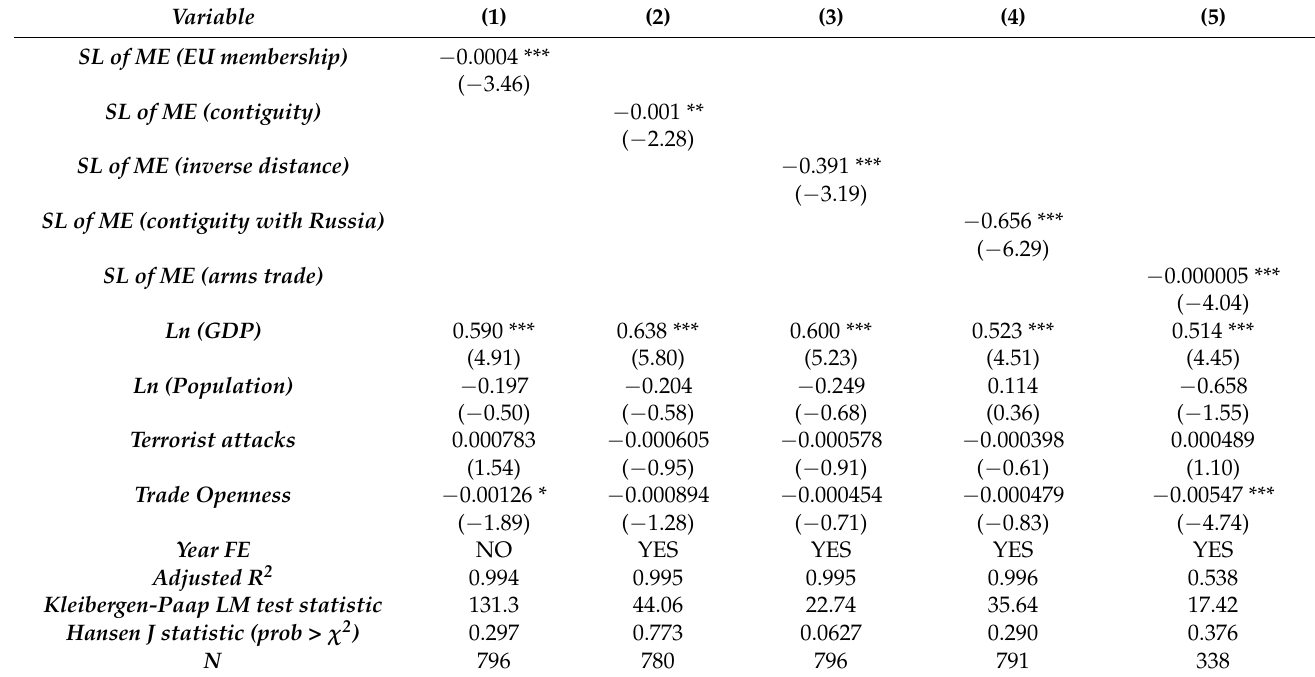
Table 3. EU and non − EU NATO countries’ military expenditure, 1990–2019.